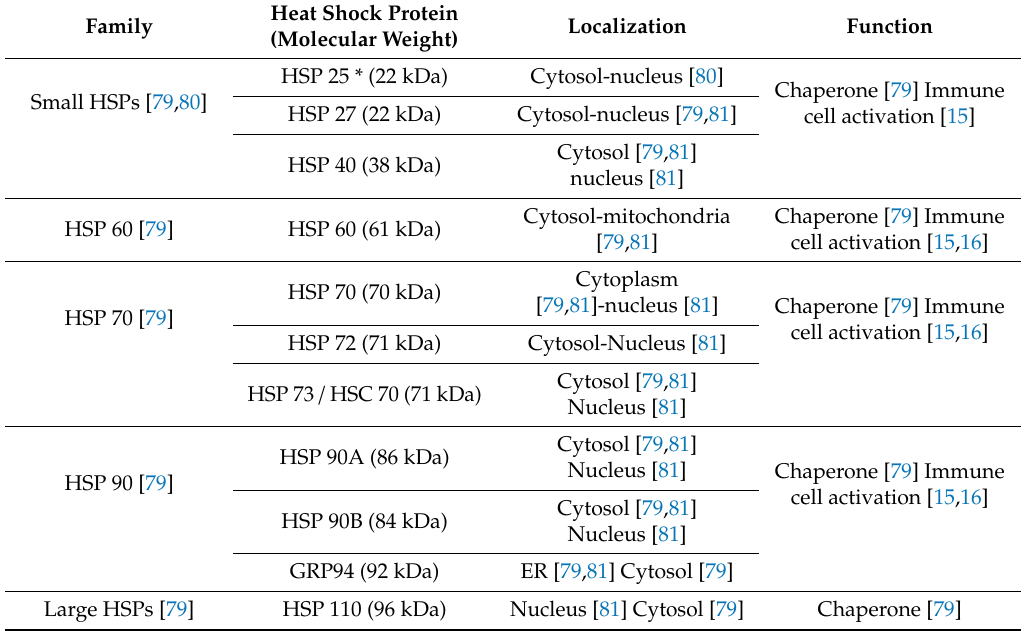
Table 1. Characteristics of Heat Shock Proteins usually investigated in sepsis. Heat Shock Protein Family Localization (Molecular Weight)